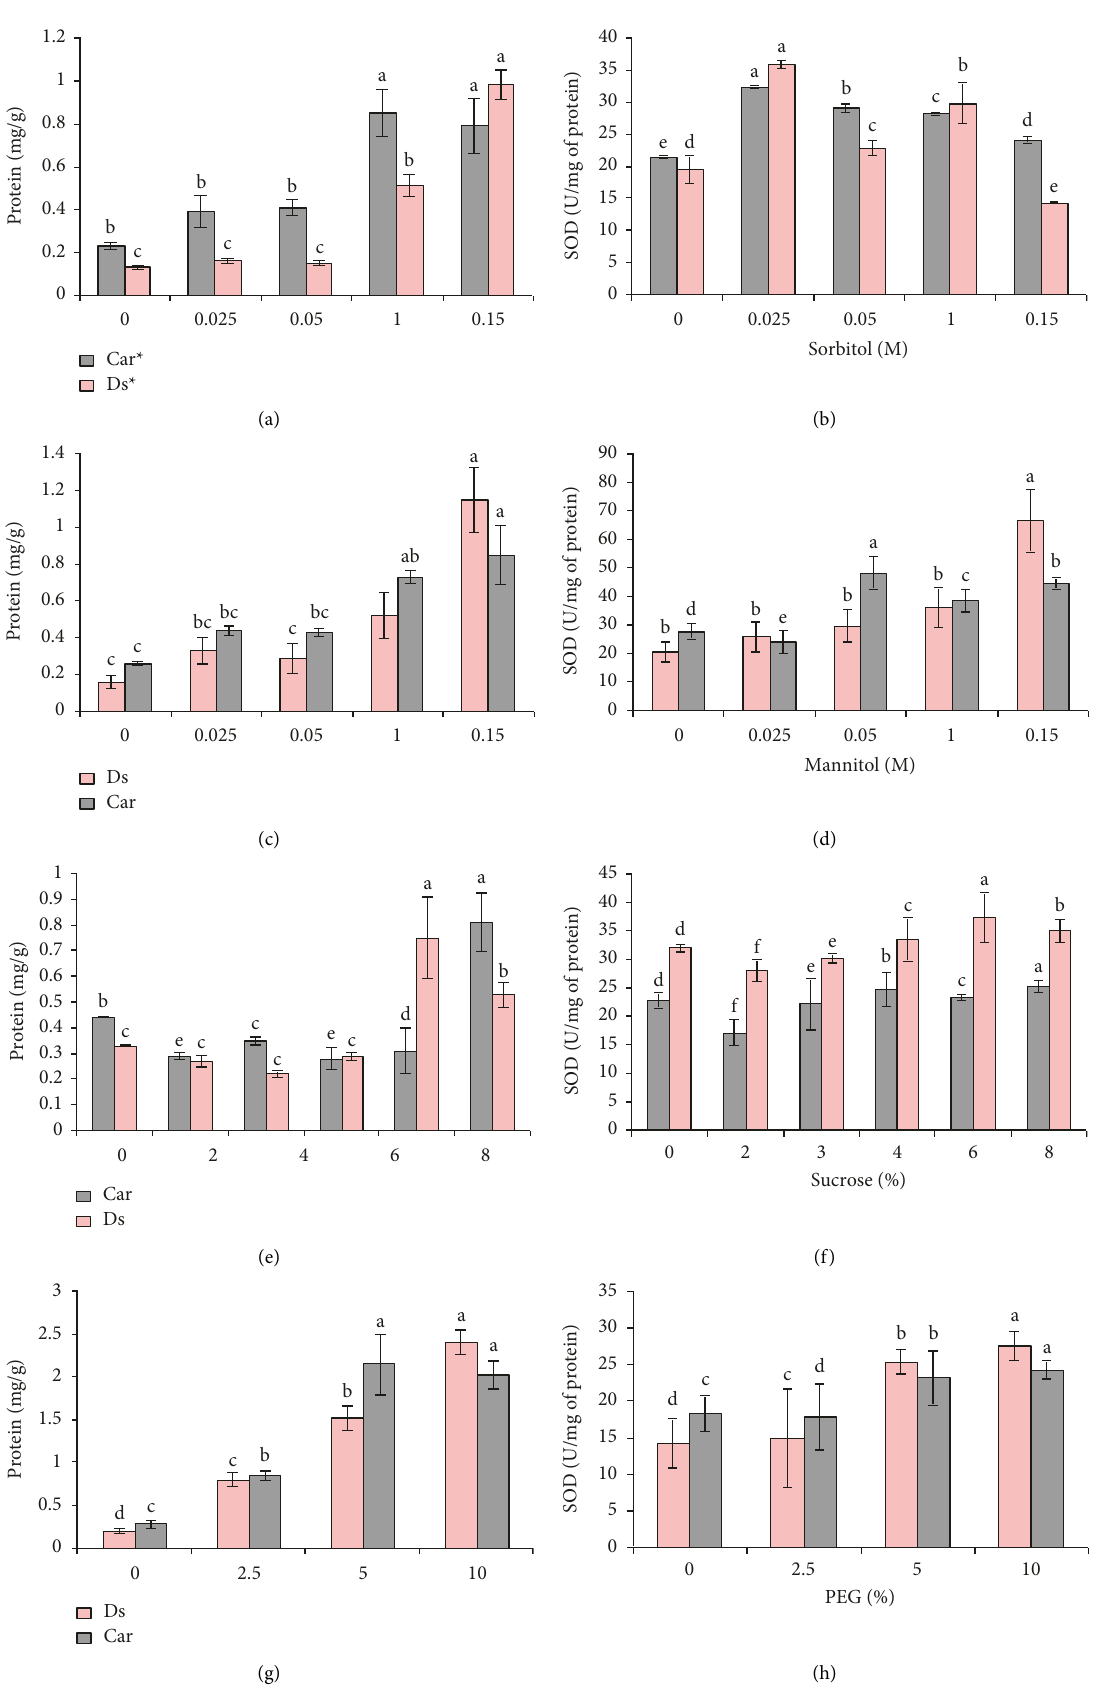
Figure 2: Protein contents and superoxide dismutase activity in potato cultivars cardinal (Car) and Desiree (Ds) in response to sorbitol (a) and (b) mannitol (c) and (d), sucrose (e) and (f) and PEG (g) and (h) induced osmotic stress. Results are the means ± S.E. of ten replicates cultures. Bars with similar letters are not significantly different at P ≤ 0 . 05 by Duncan’s multiple range